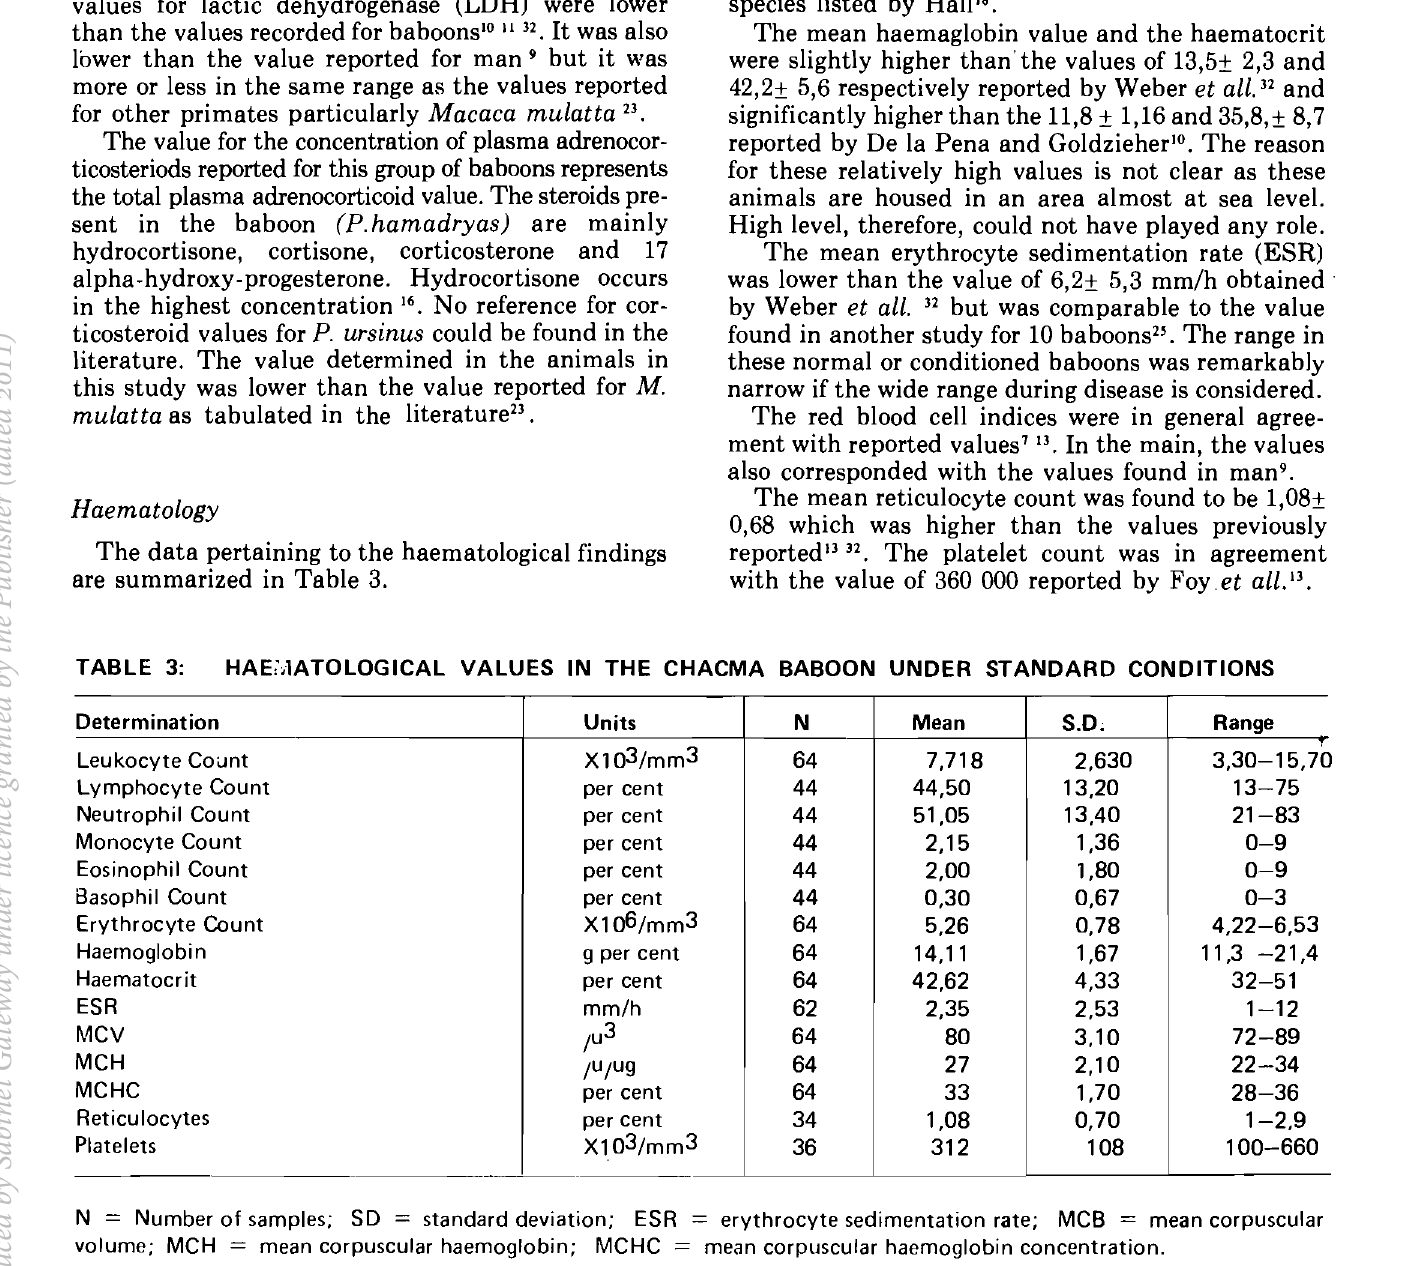
HAE;,lATOLOGICAL VALUES IN THE CHACMA BABOON UNDER STANDARD CONDITIONS